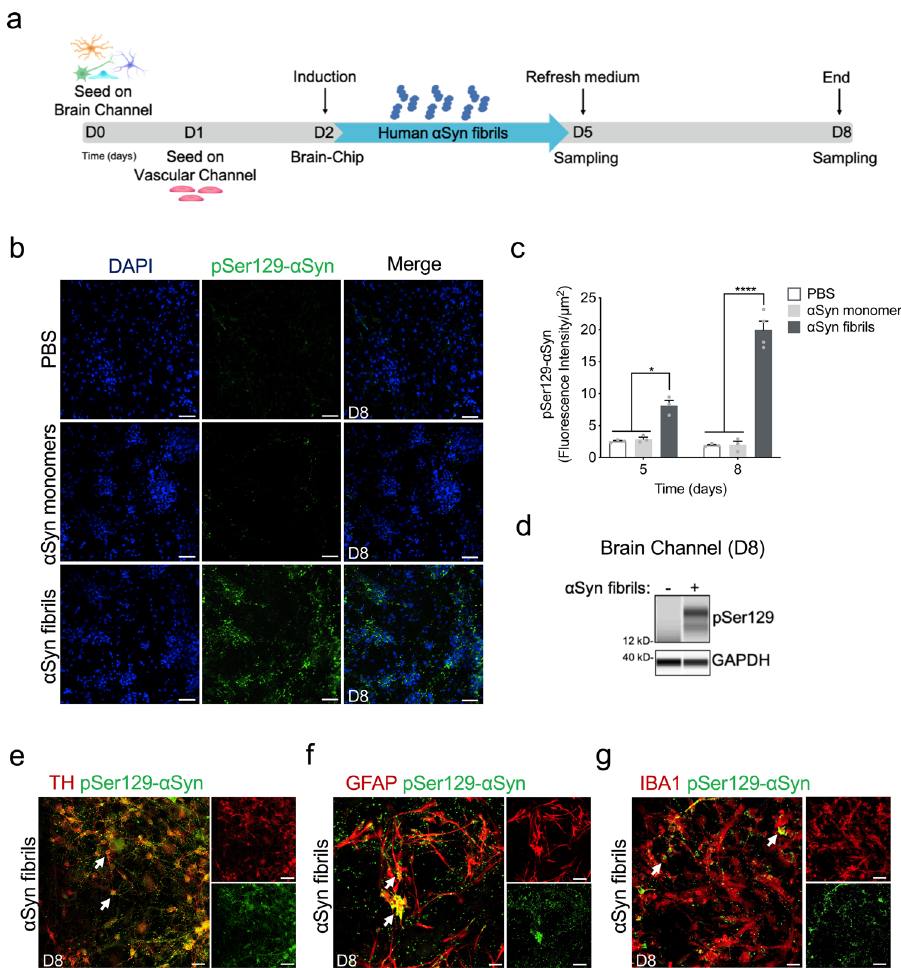
Fig. 3 Pathological α Syn accumulation in the brain channel following exposure to human α Syn fi brils. a Experimental design for assessing the effects of α Syn toxic aggregates ( fi brils) in the Substantia Nigra Brain-Chip, including the seeding in the Brain-Chip, the timeline for medium changes, as well as sampling times. b Immuno fl uorescence micrographs show the accumulation of phosphorylated α Syn (green, phospho- α Syn129 staining; blue, DAPI) at day 6 post-exposure (D8). Pathology is absent in the brain channel following exposure to monomer or PBS. Scale bars: 100 μ m. c Quantitative analysis of fl uorescence intensity in each group at day 3 and 6 post-exposure (D5 and D8, respectively). Statistical analysis is two-way ANOVA with Tukey ’ s multiple comparisons test ( n = 3 – 4 independent chips with 3~5 randomly selected different areas per chip, * P = 0.0103, **** P < 0.0001 compared to monomeric group). Error bars represent mean ± SEM. d Western blotting analysis of cell lysates from the brain channel shows signi fi cant intracellular phosphorylation of α Syn at Ser129 (MW: 18 kDa) following exposure to α Syn fi brils, whereas there was no effect upon exposure to the PBS. For loading control, equal amounts of protein were immunoblotted with GAPDH antibody (MW: 37 kDa). e Confocal images of double immunostaining for phospho- α Syn129 (green) and tyrosine hydroxylase (red, TH), in the brain channel at day 6 post-exposure (D8) to α Syn fi brils (white arrow). Scale bars: 50 μ m. f , g α Syn fi brils are taken up by astrocytes and microglia (white arrow), as evidenced by double immunostaining for phospho- α Syn129 (green) and either glial fi brillary acidic protein (red, GFAP) for astrocytes or ionized calcium-binding adaptor molecule 1 (red, IBA1) for microglia in the brain channel at day 6 post-exposure (D8) to α Syn fi brils. Scale bars: 50 μ